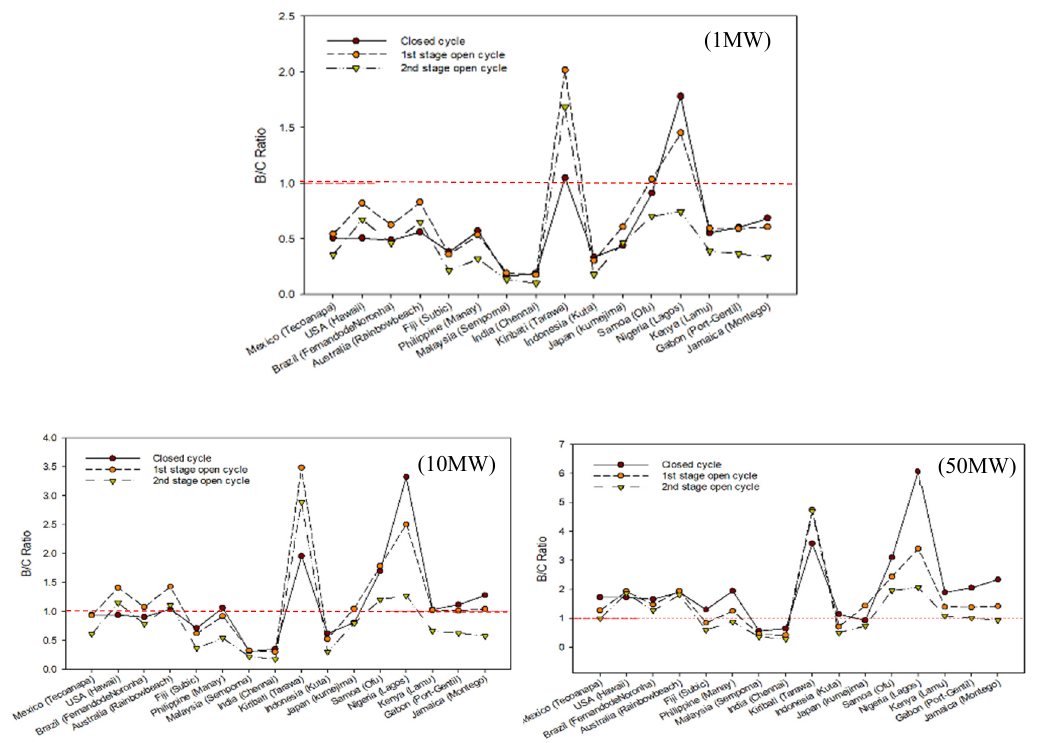
Figure 10. The benefit/cost (B/C) ratio change according to the capacity change of each country’s OTEC.